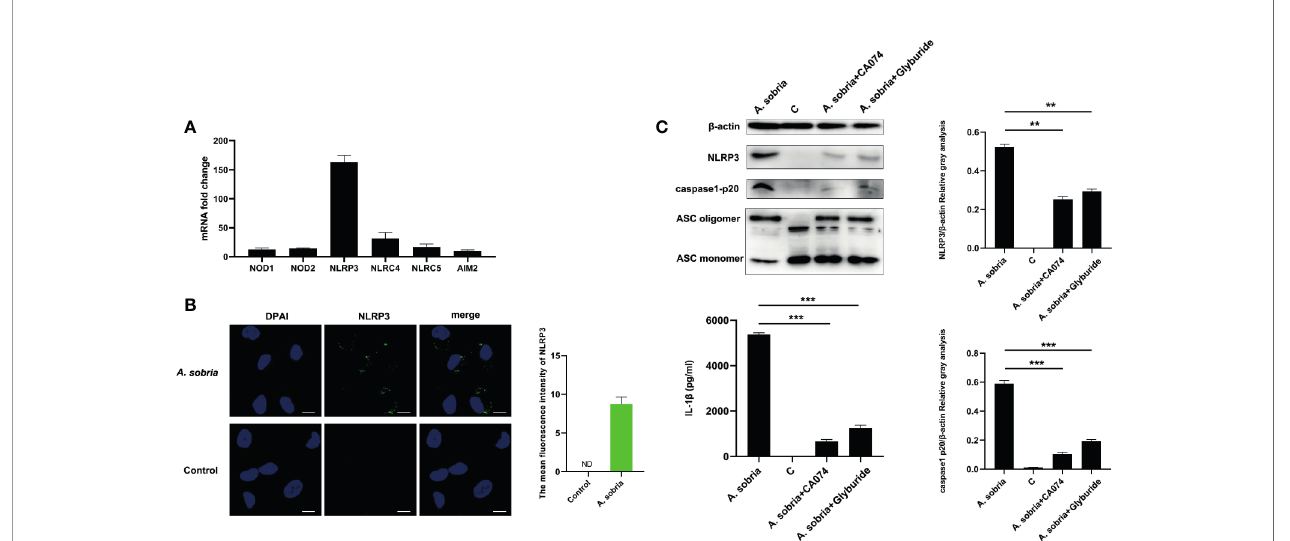
FIGURE 3 | NLRP3 in fl ammasome activation in response to A sobria stimulation and block NLRP3 in fl ammasome downregulated IL-1 b secretion. PM j s (4.5 × 10 6 cells/well in six-well plate) were infected with A sobria (MOI = 10) for 90 min, and then A sobria was discarded. After washing three times with sterile PBS, PM j s were treated with gentamicin sulfate (100 m g/ml) containing RPMI 1640 maintenance medium for 2 h to kill residual A sobria and then replaced with gentamicin sulfate (20 m g/ml) containing RPMI 1640 maintenance medium for 12 h (A) Total RNA was extracted from infected cells, and mRNA levels of NOD1, NOD2, NLRP3, NLRC4, NLRC5, and AIM2 were measured using qPCR. (B) Location of NLRP3 protein was observed using immuno fl uorescence. The green signals were FTIC-labeled NLRP3 protein, and the blue signals were DAPI-stained cell nucleus. Bar = 10 m m. The mean fl uorescence intensity of NLRP3 was measured using Fiji software, and graph was generated from two dependent assays. (C) PM j s were pretreated with either CA-074 methyl ester (25 m M) or Glyburide (50 m M) for 1 h prior to infection. The protein expression levels of NLRP3 in the cells, caspase-1 p20 levels in the supernatants, and the ASC oligomerization levels in the cross-linked cell pellets were detected using western blotting. Secretion of mature IL-1 b were measured using ELISA. The relative gray values of NLRP3 and caspase-1 p20 were normalized to b -actin through Image. Data were presented as mean ± Standard Deviation from three independent assays with three technical repeats. Signi fi cant difference was analyzed using SPSS software, and graph was generated using GraphPad Prism 8 software. ** represents p < 0.01 and *** represents p <